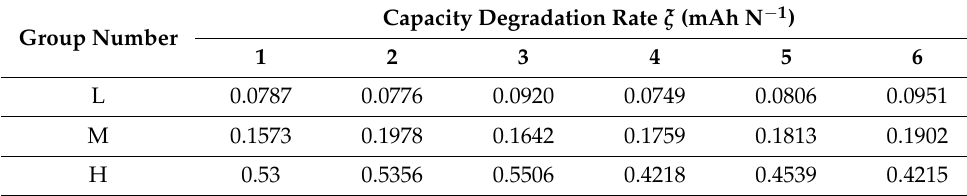
Table 2. Battery capacity degradation